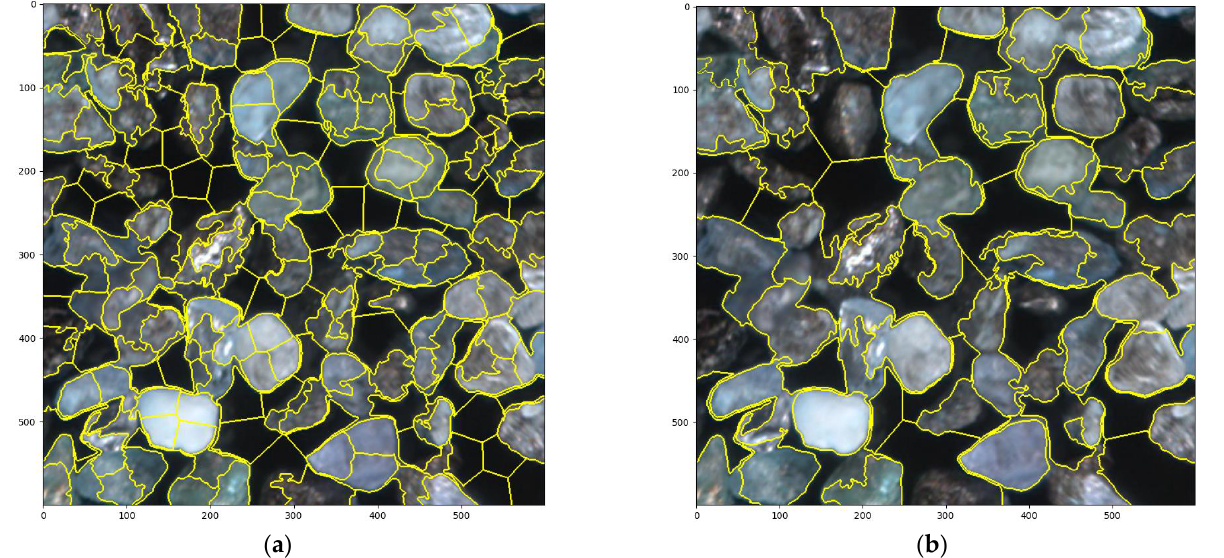
Figure 4. Visual comparison of the detected superpixel boundaries of grains using the method of Maitre et al. ( a ) and our approach ( b ) [22].